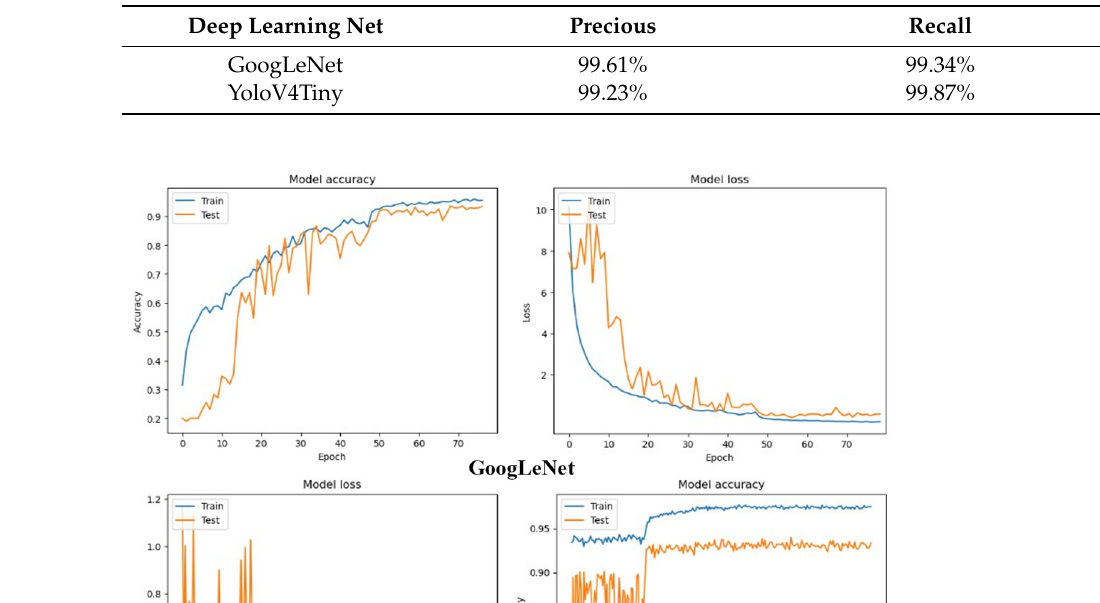
Table 3. Deep learning network training data table.